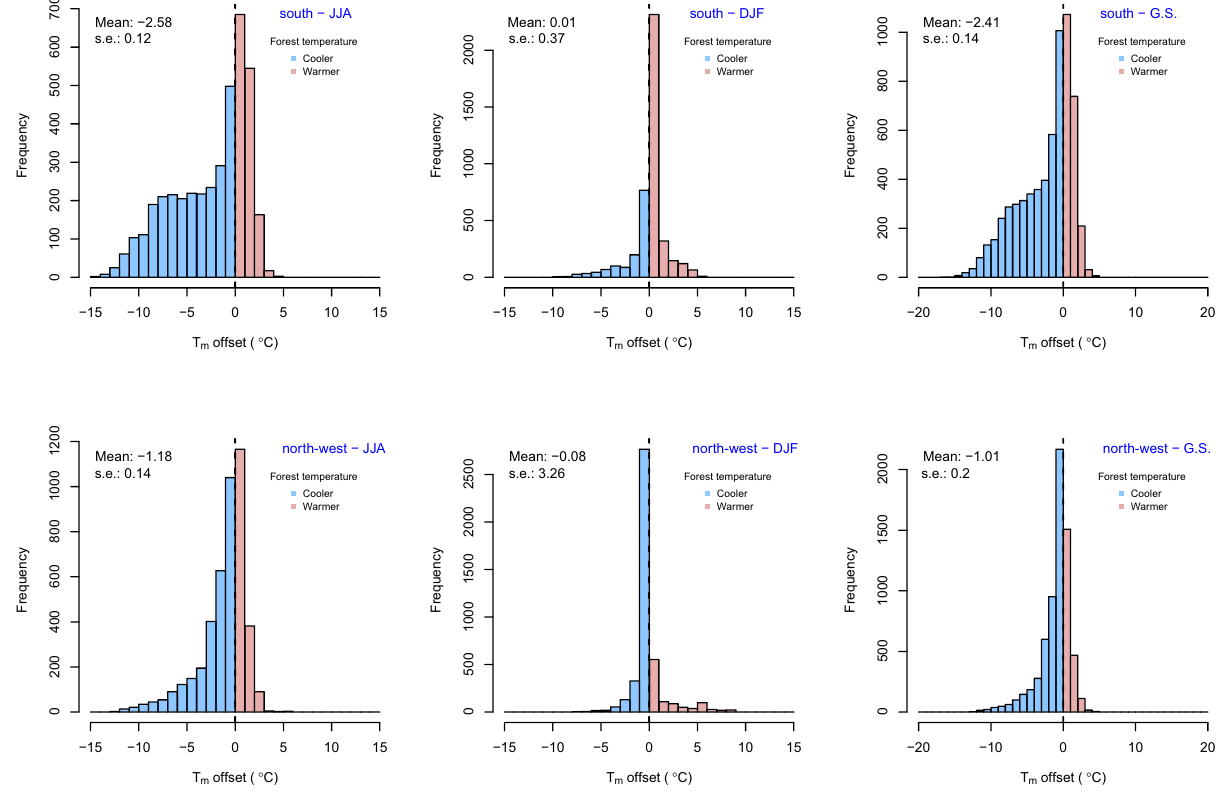
Figure 3. Temperature offset values for average mean temperatures during summer (JJA), winter (DJF), and the growing season (G.S., i.e., from May to September). Mean temperatures are consistently cooler under-canopy (microclimate) compared to open field (macroclimate). Temperature offsets (mean ± s.e.) are based on mixed- effects models with months, days, and hours as nested random-effect terms (the full statistics are reported in Supplementary Material Table S2). Y-axis scales are not